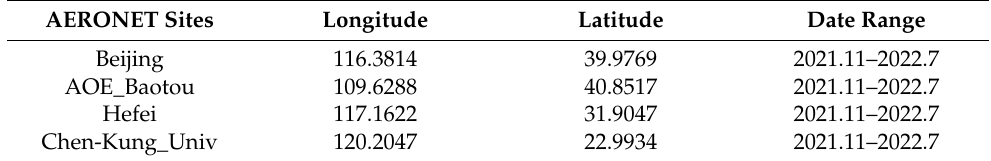
Table 3. AERONET data for